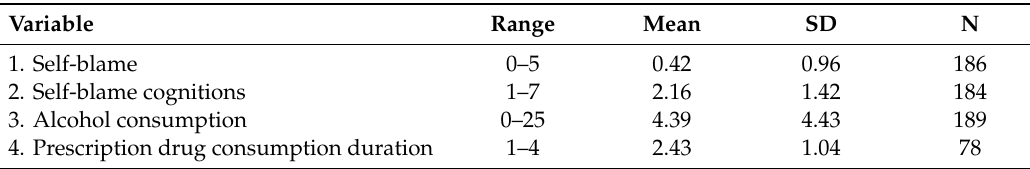
Table 2. Descriptive statistics.